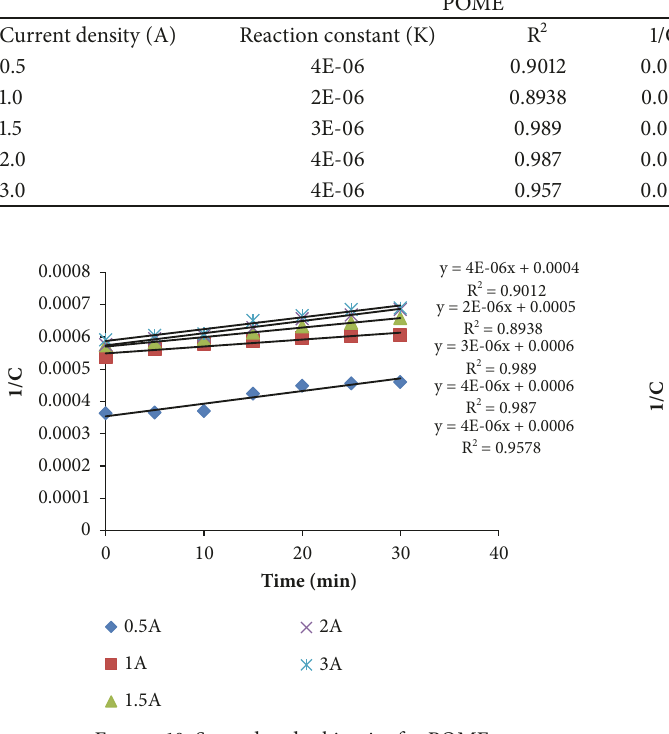
Figure 10: Second-order kinetics for POME. Figure 11: Second-order kinetics for